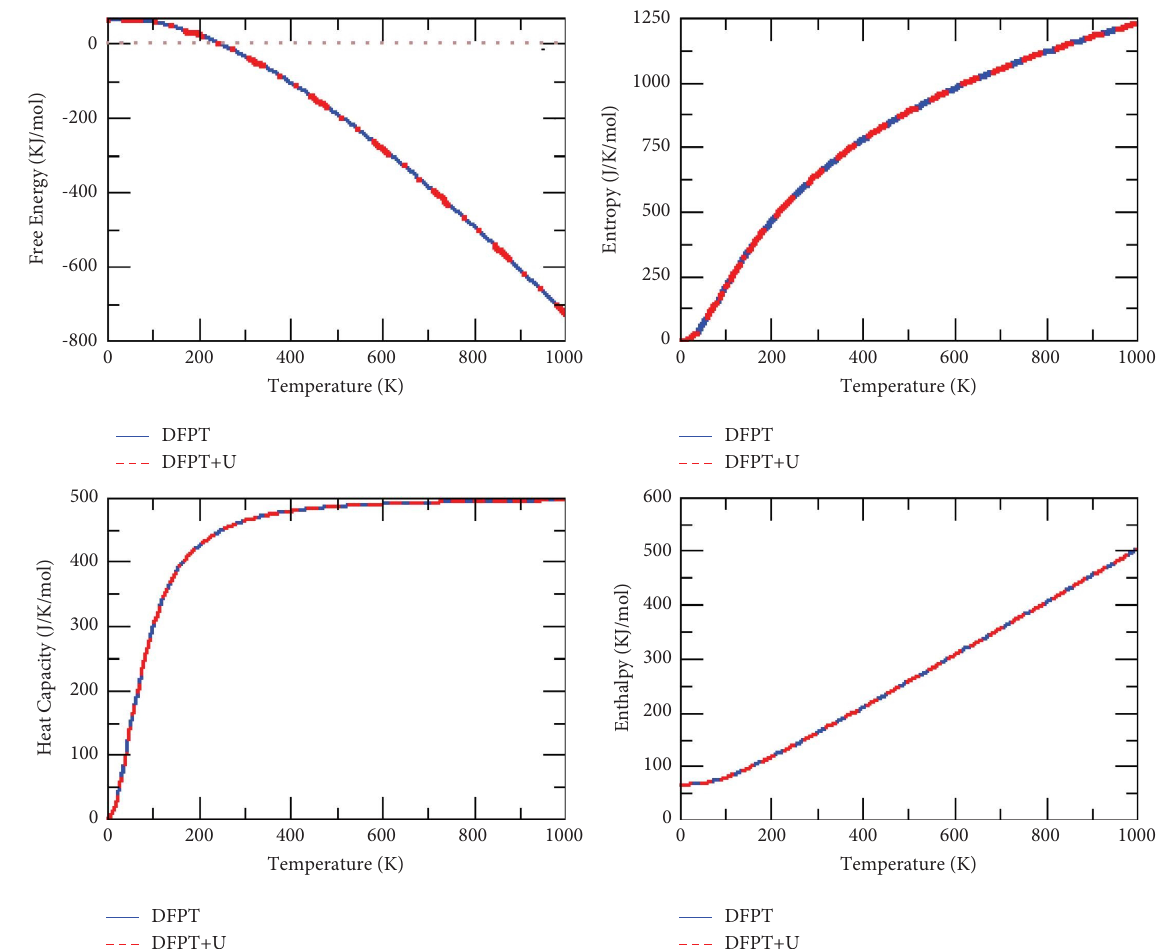
Figure 7: Free energy, entropy, and specifc heat of CaHfS